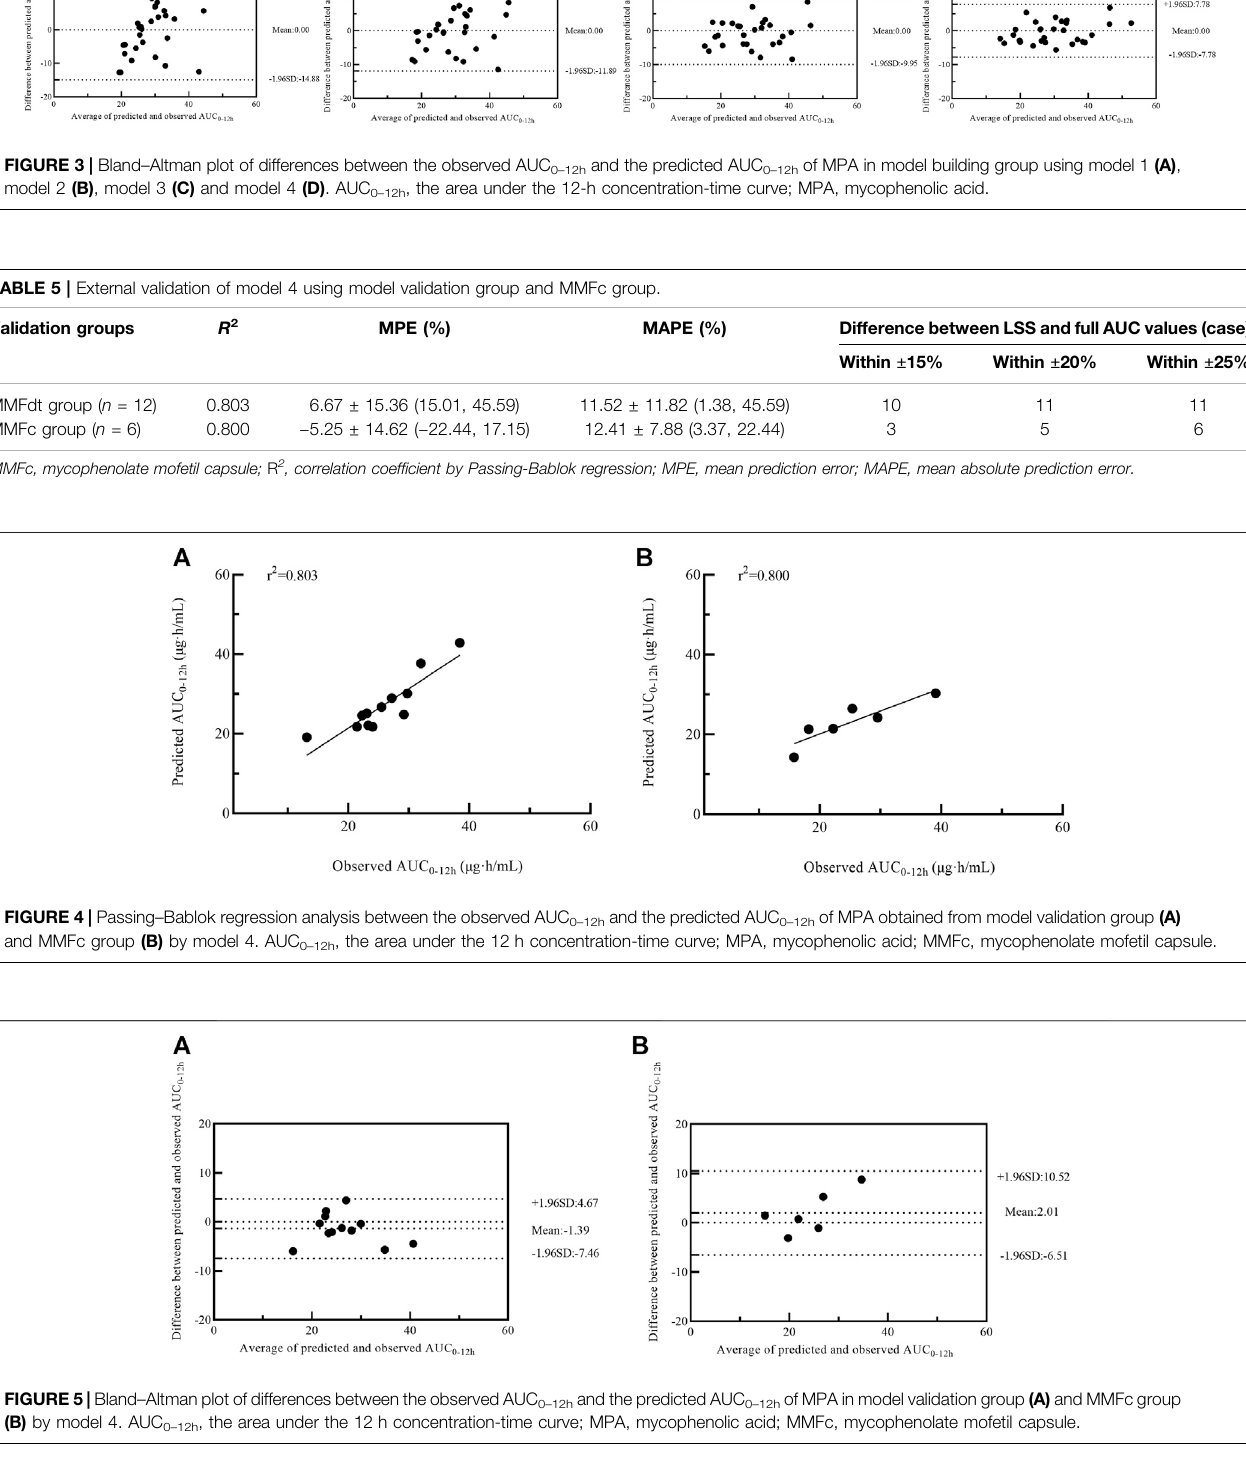
Frontiers in Pharmacology |